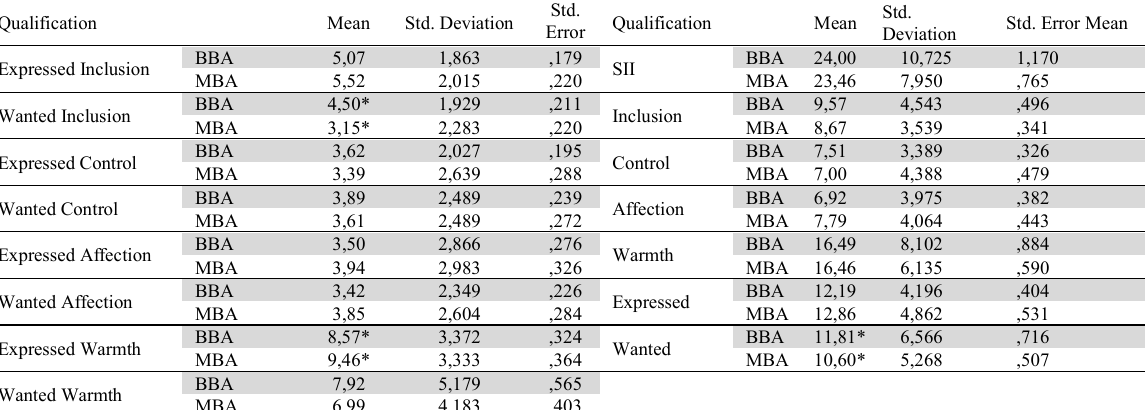
The analysis of the mean difference Qualification Mean Std. Deviation